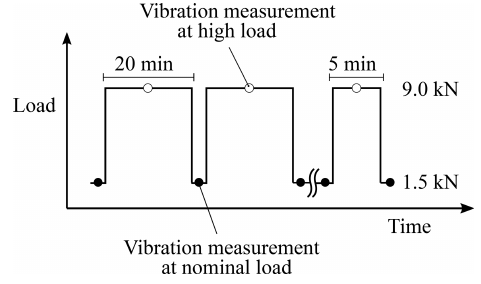
Figure 2. The load was temporarily increased from 1.5 to 9kN to accelerate the lifetime of the bearing.